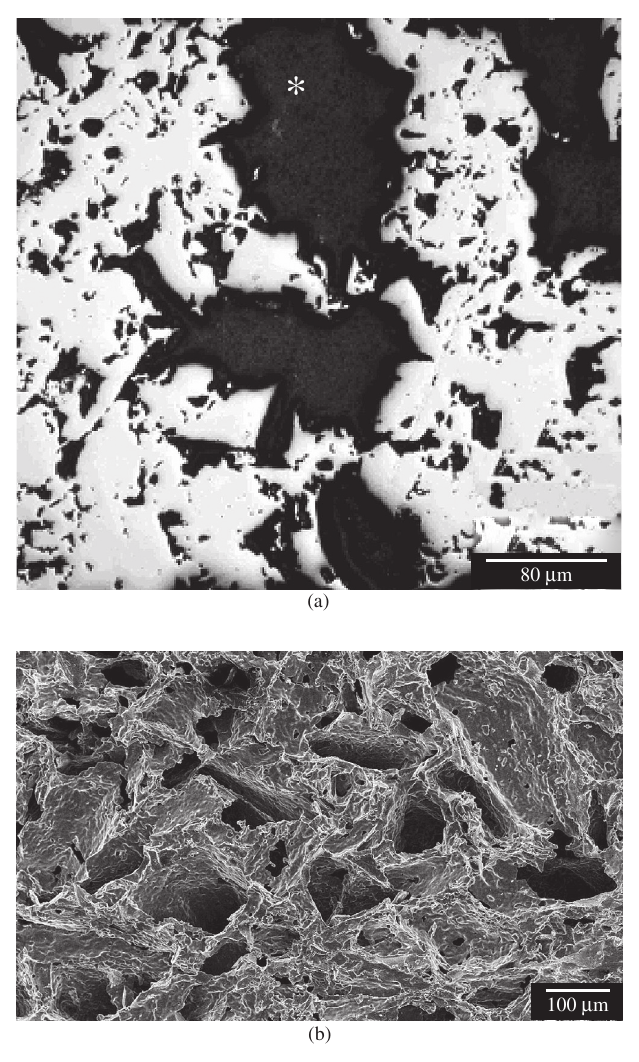
Figure 2. SEM photomicrograph of a metallographic sample: a) porous structure in the center of the scaffolds, with interconnected pores (*); and b) porous structure in the superficial portion of the scaffolds.